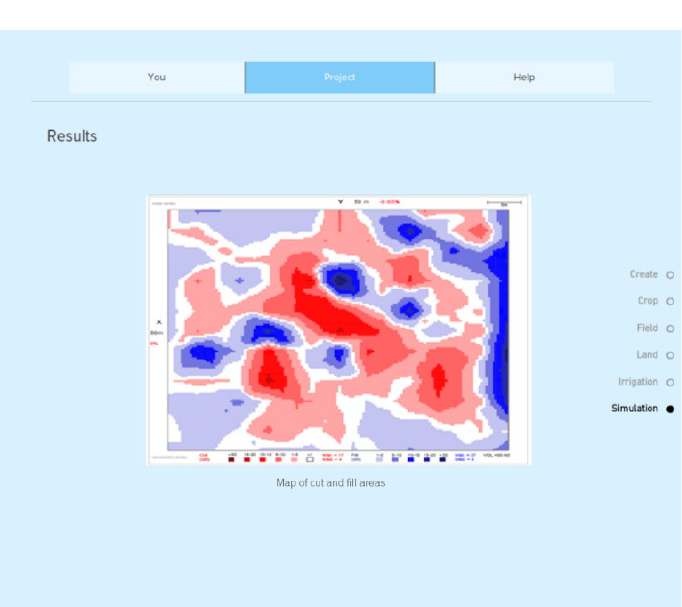
Figure 5. Example layout of land leveling simulation tool for a field parcel, showing the map of cut and fill